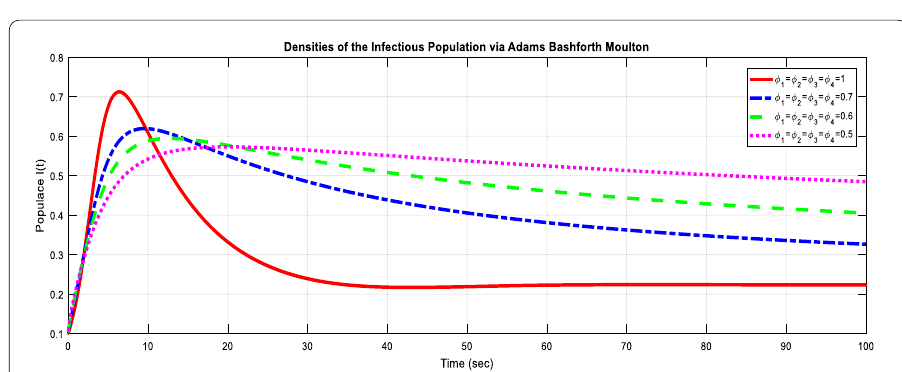
Figure 31 Dynamic of populace I ( t ) by varying the value of φ